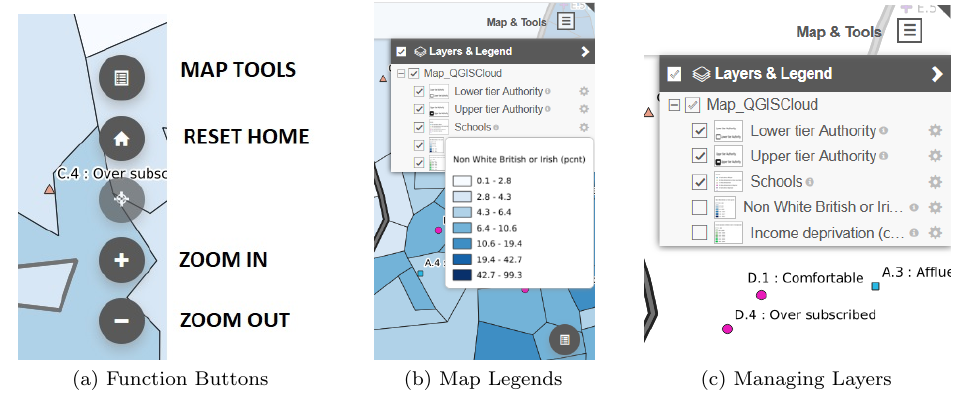
Figure A.1: Function buttons and Map